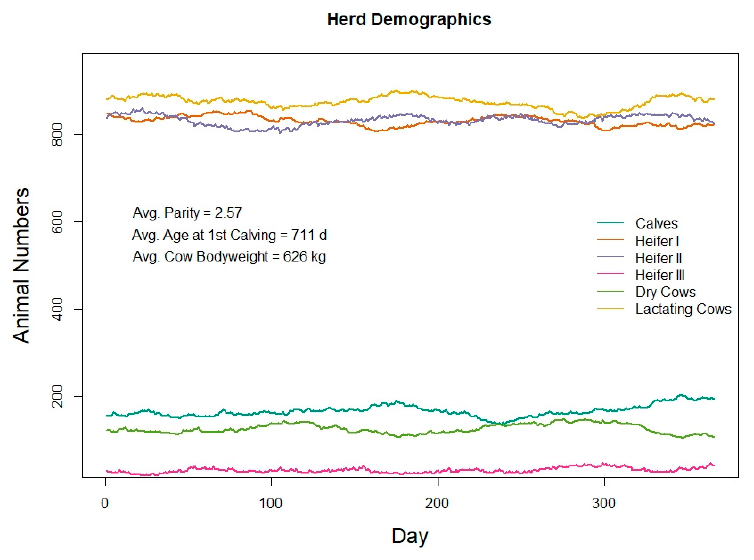
Figure 4. Herd demographics of a 1000-cow Holstein dairy herd simulated in the RuFaS model for 365 days.